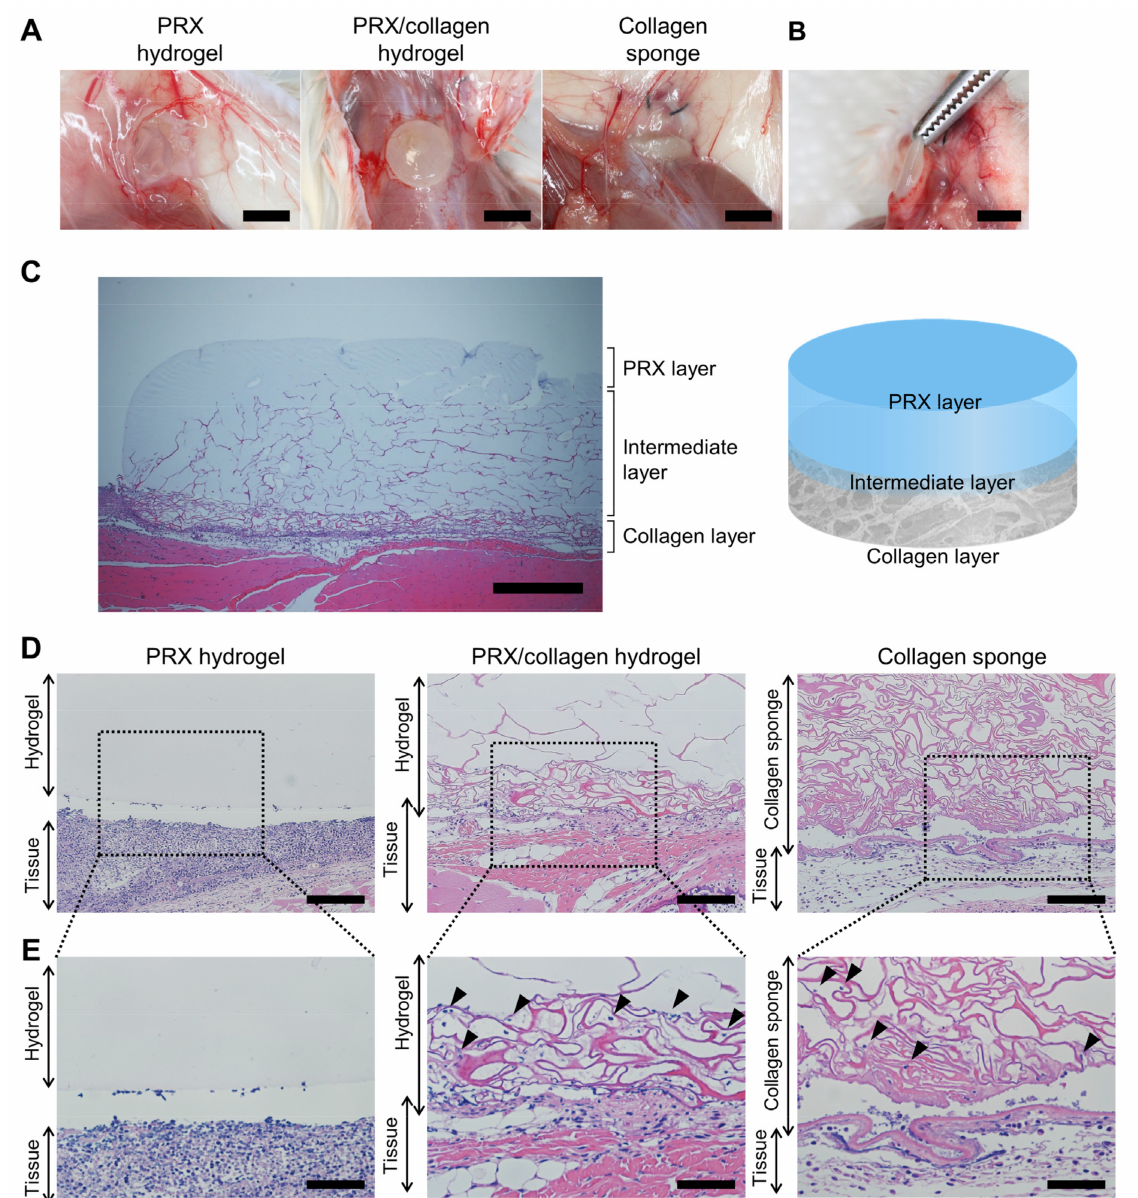
Figure 6. ( A ) Photographs of the polyrotaxane (PRX) hydrogel, PRX/collagen hydrogel, and collagen sponge after subcutaneous implantation on mice for 24 h (scale bar: 5 mm). ( B ) Photograph of PRX/collagen hydrogel tightly adhering to the muscle (scale bar: 5 mm). ( C ) Hematoxylin and eosin (HE) staining of a cross-section of PRX/collagen hydrogel (scale bar: 0.5 mm). ( D ) Histological observation of PRX hydrogels, PRX/collagen hydrogels, and collagen sponges and the surrounding tissues after subcutaneous implantation for 24 h; scale bar: 100 µ m, ( E ) scale bar: 50 µ m. The black arrows indicate migrated cells in the collagen